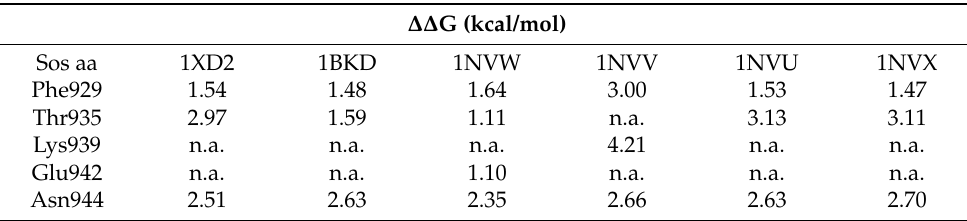
Table 1. Predicted ∆∆ G values from the alanine mutations on Sos binding interface amino acids retrieved by the Robetta Computational Interface Alanine Scanning Server